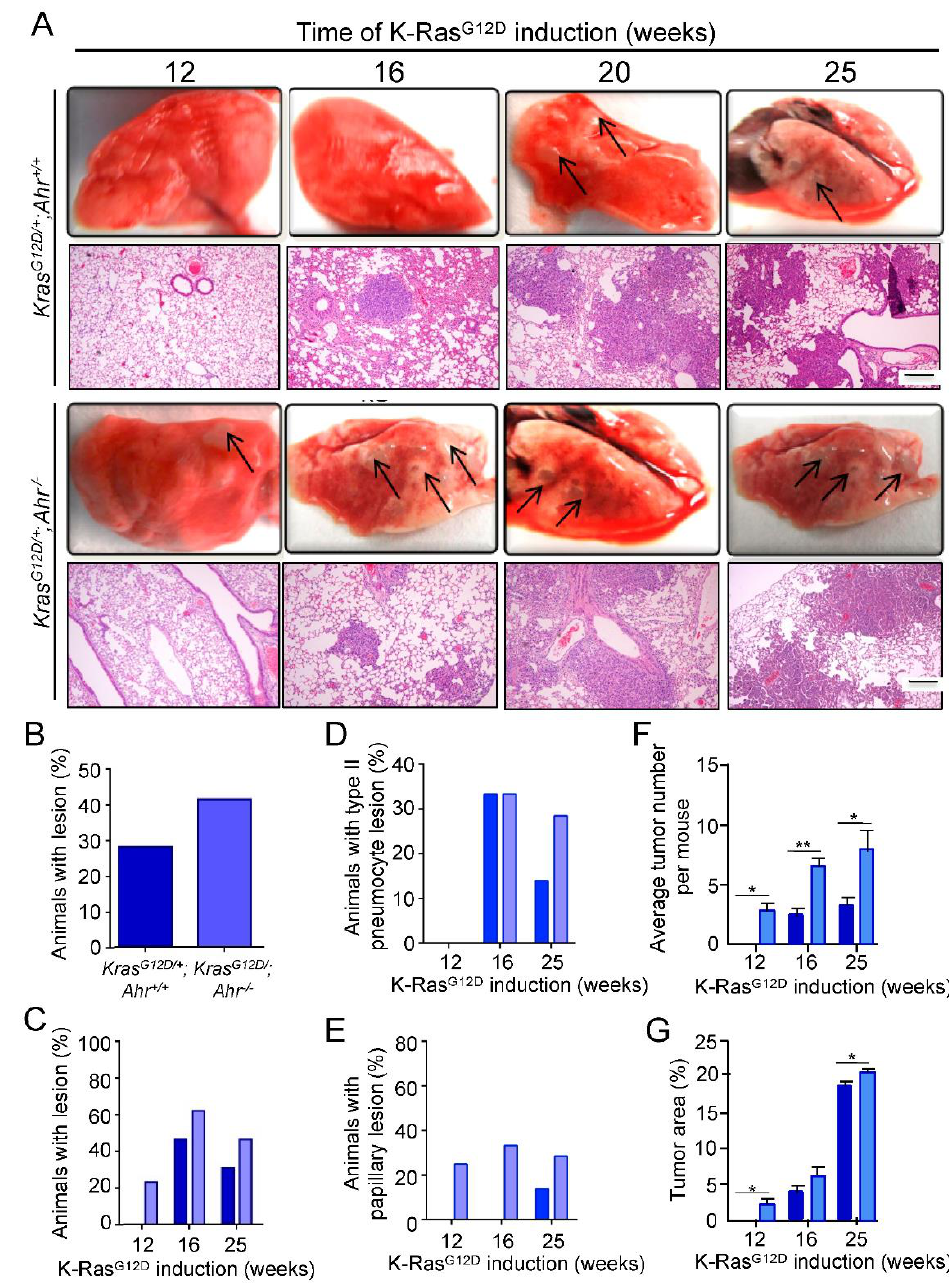
Figure 1. Lung lesions induced by K-Ras G12D are modulated by the Ahr genotype. ( A ) K-Ras G12D/+ ; Ahr +/+ and K-Ras G12D/+ ; Ahr − / − mice were treated with AdenoCre and the lung lesions generated analyzed for up to 25 weeks macroscopically (upper panels) and histologically by H&E staining (lower panels). ( B ) Histological quantification of the percentage of mice of each genotype developing NSCLC lesions. ( C ) Histological quantification of the percentage of mice with NSCLC lesions upon the time of K-Ras G12D activation at up to 25 weeks. ( D , E ) Percentage of mice developing type-II pneumocyte hyperplasia ( D ) or papillary lesions ( E ). ( F , G ) Quantification of overall tumor burden ( F ) and the total tumoral area comprising endobronchial hyperplasia, type-II pneumocyte hyperplasia (reminiscent of adenocarcinoma) and papillary lesions were measured using Fiji ImageJ software ( G ). Groups of 4–5 mice were used for each genotype and time point. Tumor incidence is represented as the percentage of affected mice with respect to the total number of mice induced. Bar corresponds to 100 µ m. Data are shown as mean + SD (* p < 0.05; ** p < 0.01).